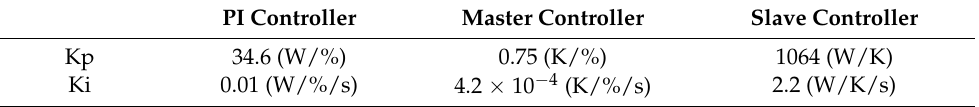
Table 3. Settings of the controllers from Figure 23.